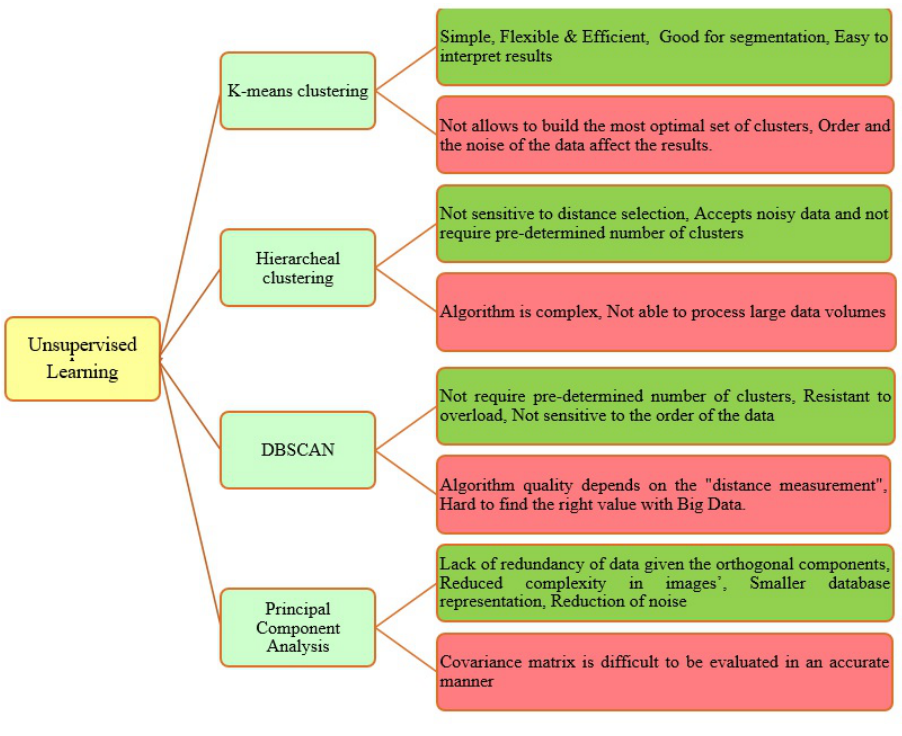
Figure 11. Pros. (Light Green) and Convs. (Light Red) of Unsupervised learning models [81].